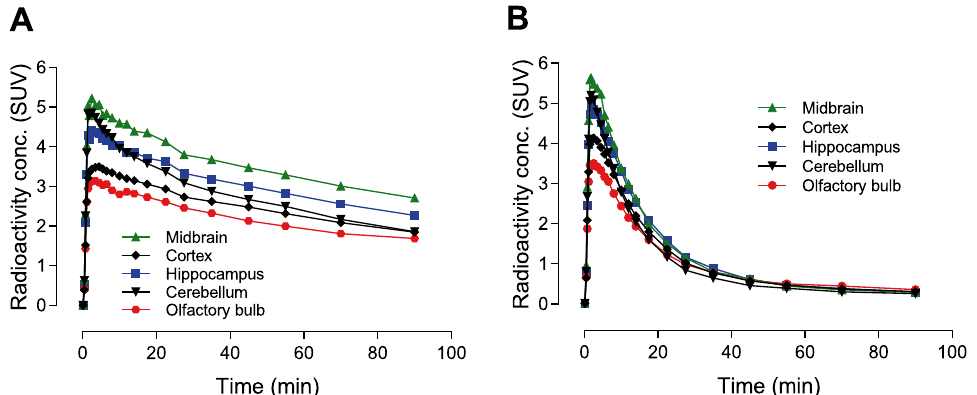
Fig. 3 Time‑activity curves for 11 C‑( )‑NR2B‑Me in different regions of rat brain at baseline ( A ) and after pretreatment with Ro‑25‑6981 (0.25 mg/ − kg) ( B ). Data are for n =